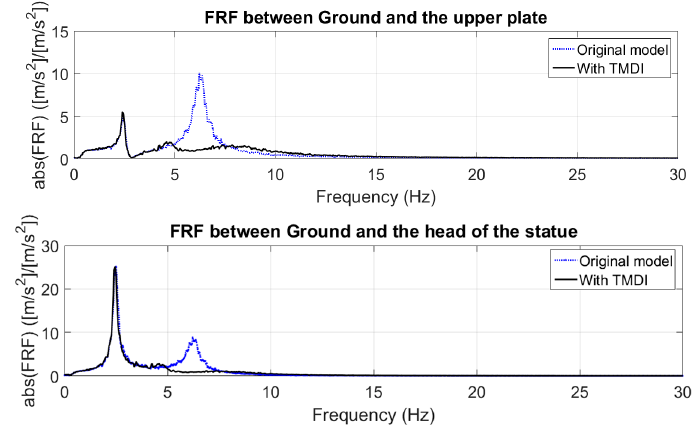
Figure 12. FRFs obtained from the multi-degree-of-freedom (MDOF) model without and with TMDIs for case 1.